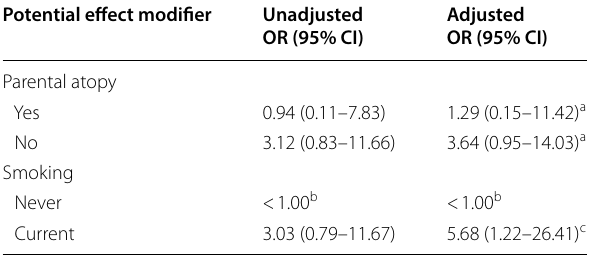
ACOS Asthma-COPD Overlap Syndrome, CI confidence interval, OR odds ratio a Adjusted for age and gender b No. of cases exposed to mold odor c Adjusted for age, gender and